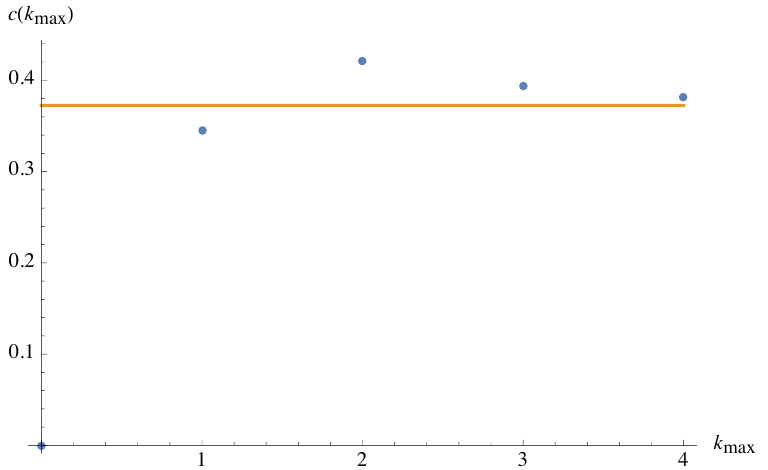
Figure 2. The blue dots show c ( k max ), plotted agains k max . The orange line on the r.h.s. is approximately 0 : 372 | the exact OPE coe(cid:14)cient. The last point on the r.h.s. is approximately 0 : 381 which is about 2% from 0 :